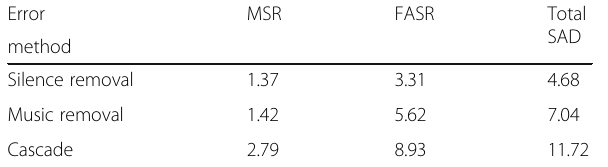
Table 4 Best DER result obtained for both speaker models